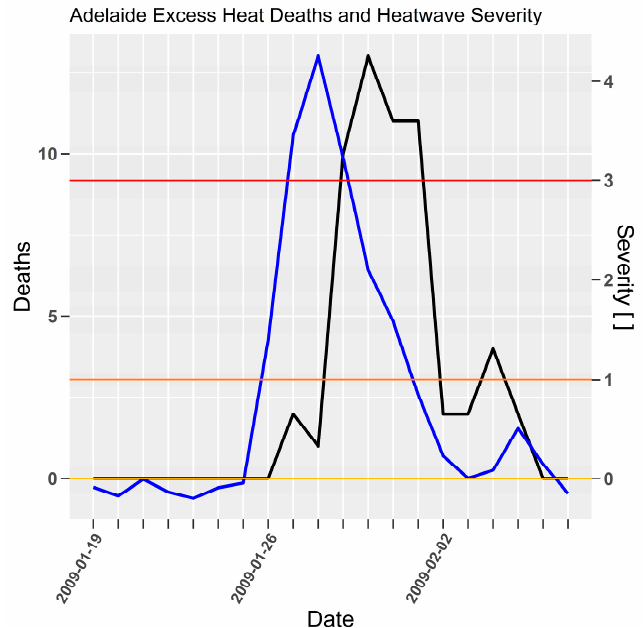
Figure 1. Heat related mortality (black line, left axis) and EHF severity (blue line, right axis) for Adelaide 2009 extreme heatwave [35] (p. 21).